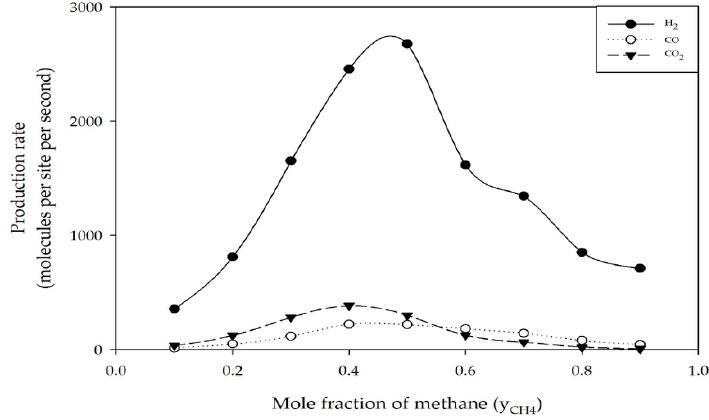
Figure 4. Production rates as a function of the mole fraction of methane; T = 823 K and P = 1 bar.